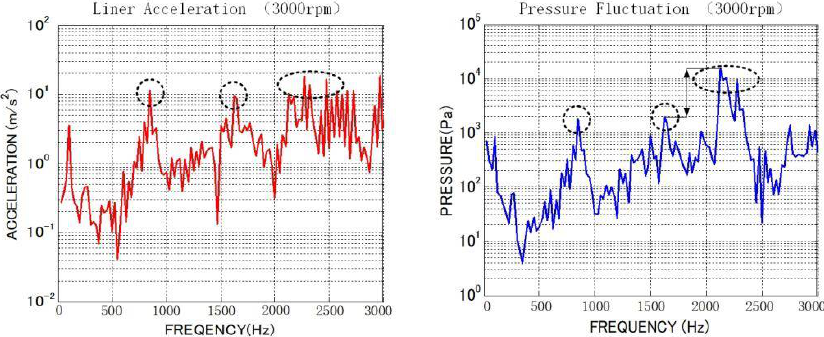
Figure 17. Liner acceleration and coolant pressure spectrum at the revolution speed of 3000 rpm.